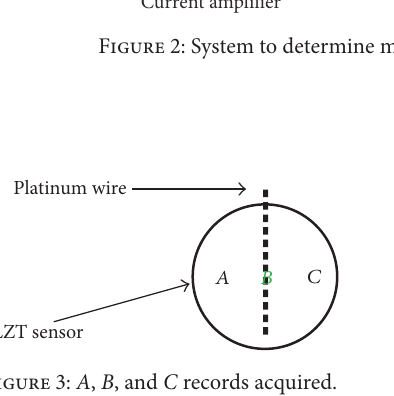
Figure 5: Diagram arrangement of data acquisition system for recording ECG data and cardiac